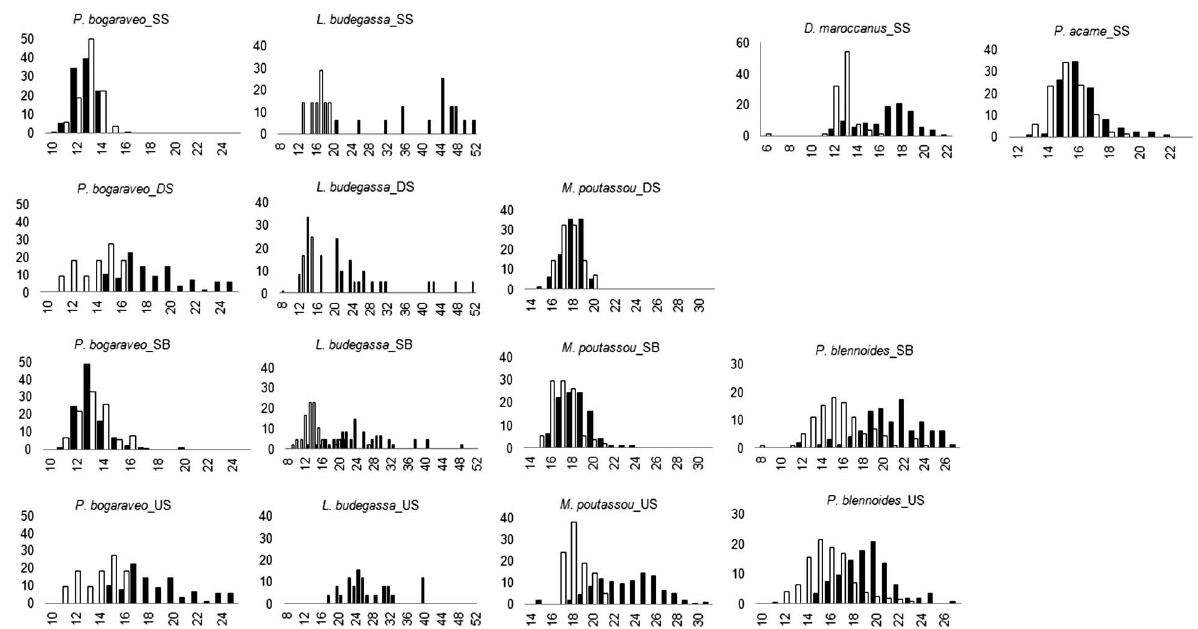
Fig. 5. – Size composition of main species ( P. bogaraveo, L. budegassa , D. maroccanus , P. acarne , M. poutassou and P. blennoides ) without minimum legal landing size by depth strata (SS, shallow shelf; DS, deep shelf; SB, shelf break; US, upper slope), showing the landed (black bars) and discarded (white bars)